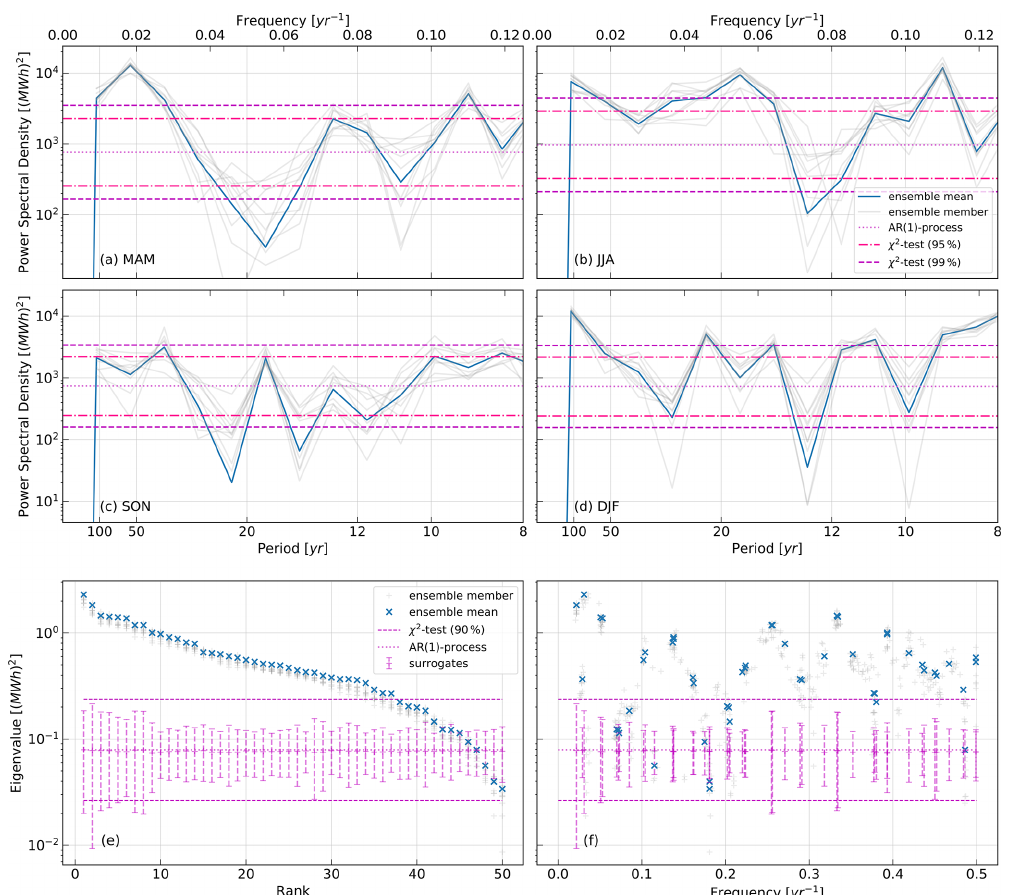
Figure 3. Spectra of wind power potential for Portuguese Atlantic Coast. The panels (a) – (d) show the PSD of each season (blue denotes ensemble mean, gray ensemble members). The confidence level of 95% (dashed) and 99% (dash-dotted) is given. The panels (e) and (f) show the eigenspectrum of SSA (blue denotes ensemble mean, gray ensemble members). Eigenvalues are ordered by rank in (e) and by frequency in (f) with confidence interval given by the inner 90% of the surrogates and a χ 2 -test (90%).